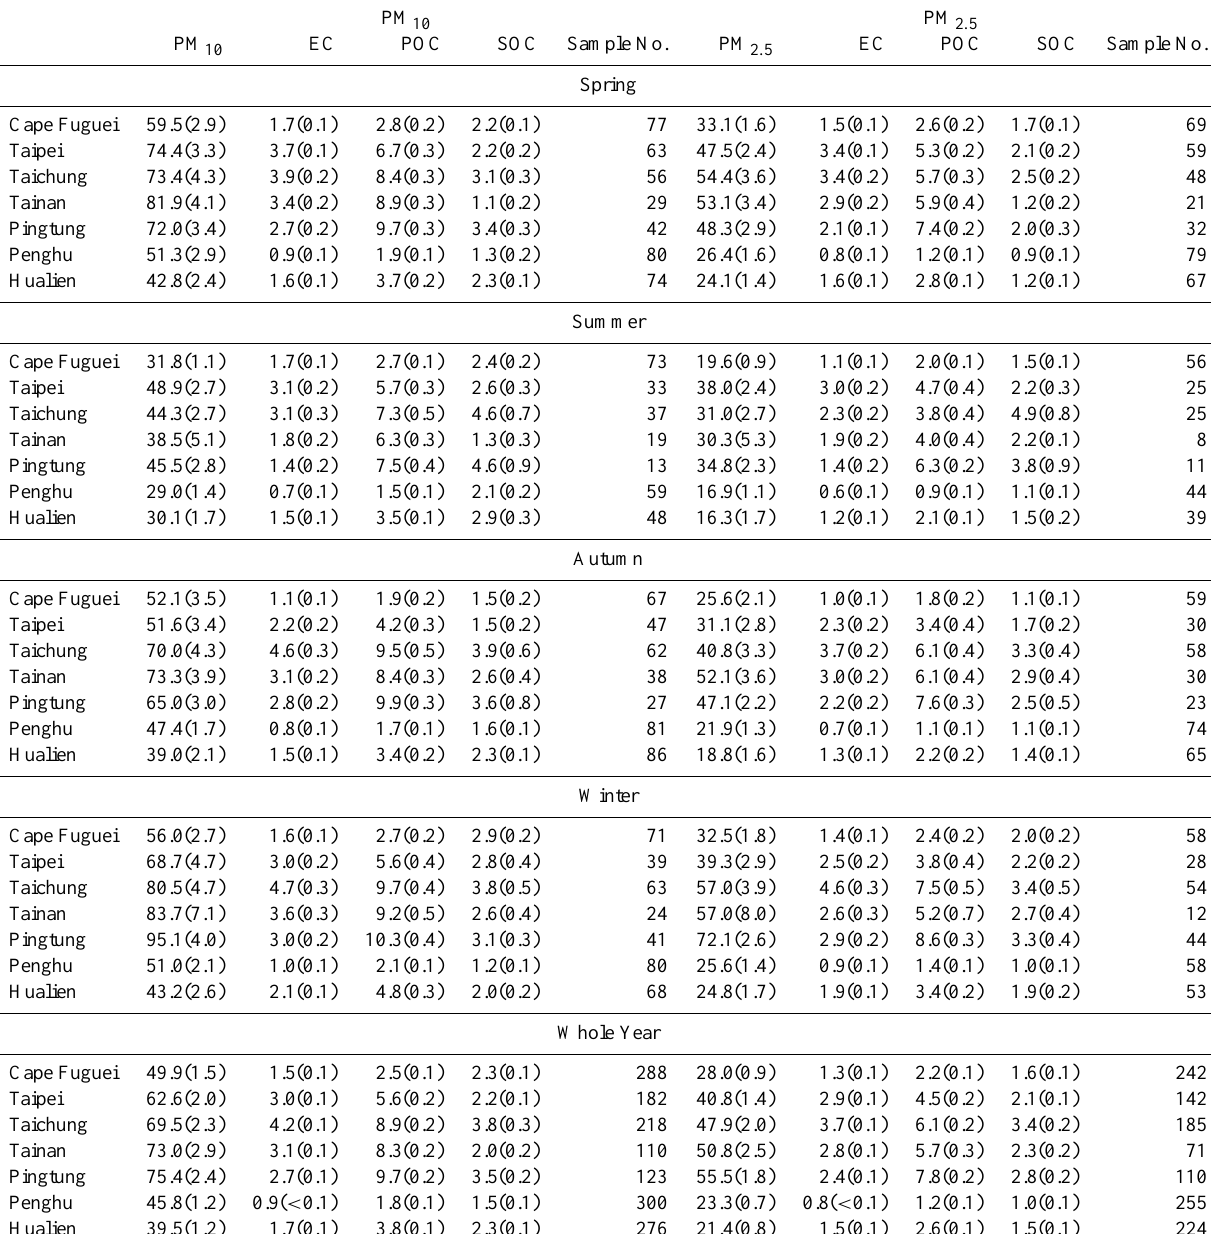
Table 3. Seasonal means of the mass concentrations of EC, POC and SOC for